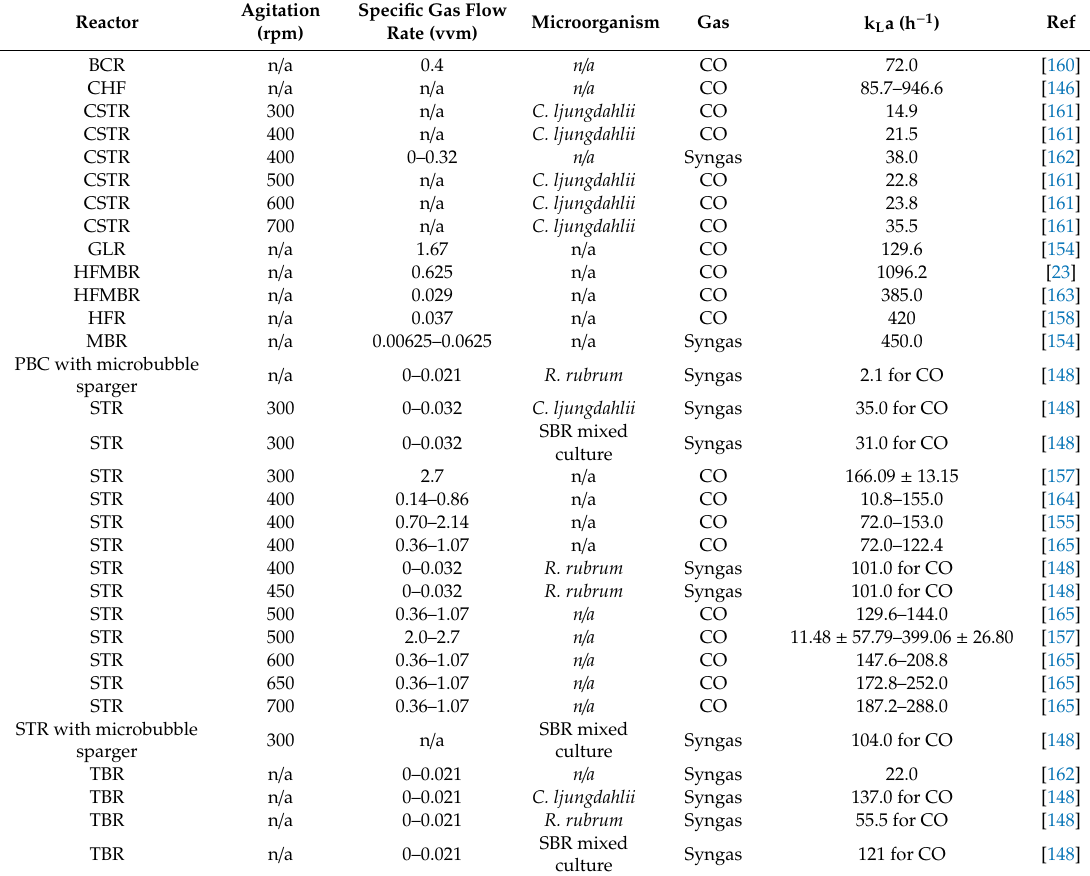
Table 3. Mass transfer related to synthesis gas fermentation reported in literature using water as the liquid